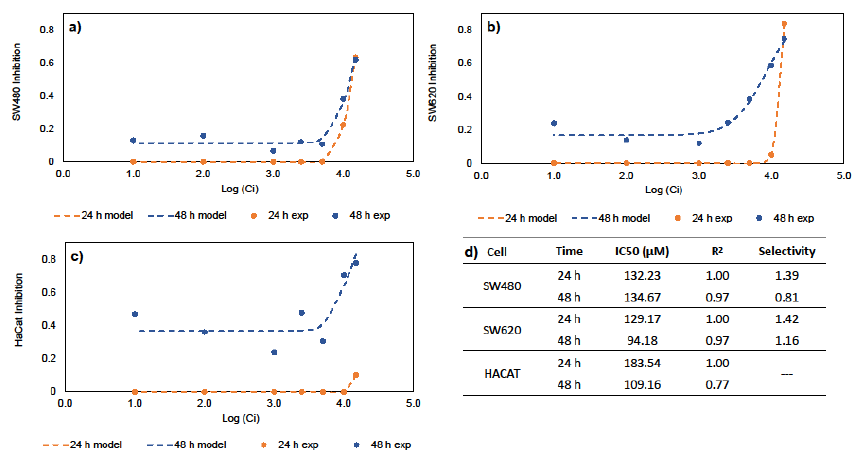
Figure 1. In vitro studies for IC50 and selectivity; ( a ) Hill equation for SW480 cells; ( b ) Hill equation for SW620 cells; ( c ) Hill equation for HaCaT cells; ( d ) IC50 for free genistein and selectivity.